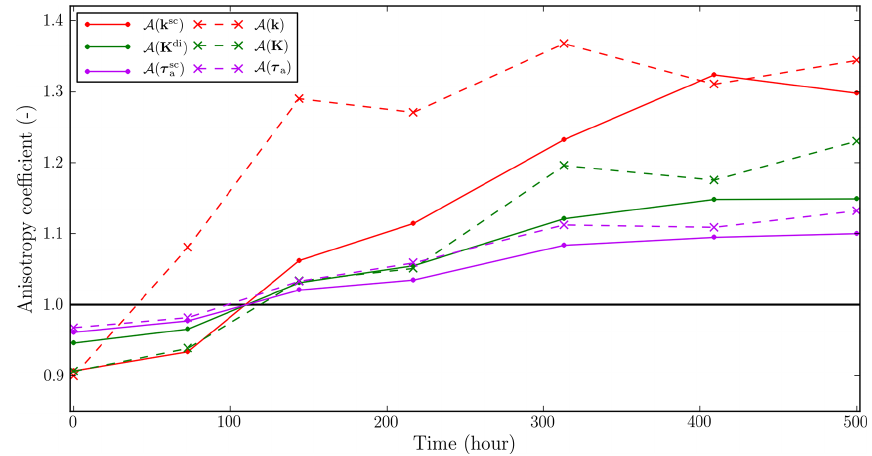
Figure 12. Time evolution of the anisotropy coefficients of air tortuosity, thermal conductivity and permeability. Comparison between coefficients deduced from values computed on 3-D images (dashed lines) and values given by analytical estimates (solid lines).